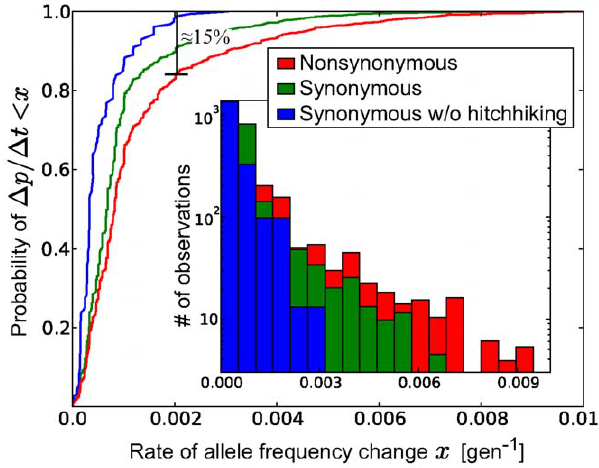
Figure 3. Bootstrap distribution of the recombination rate estimate. The variability of the recombination rate estimator was assessed by repeating the fit 500 times with data of eleven patients sampled with replacement from the original eleven patients. The mean, median, and standarddeviation of thedistribution are given in thefigure.